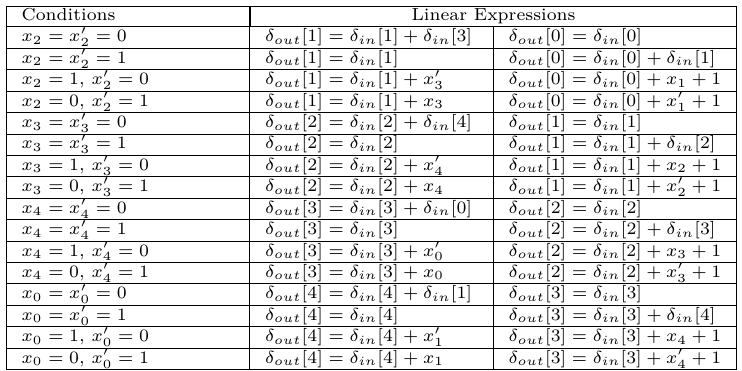
Table 8: Linear expressions of the output differences of χ with known input bits in different positions.